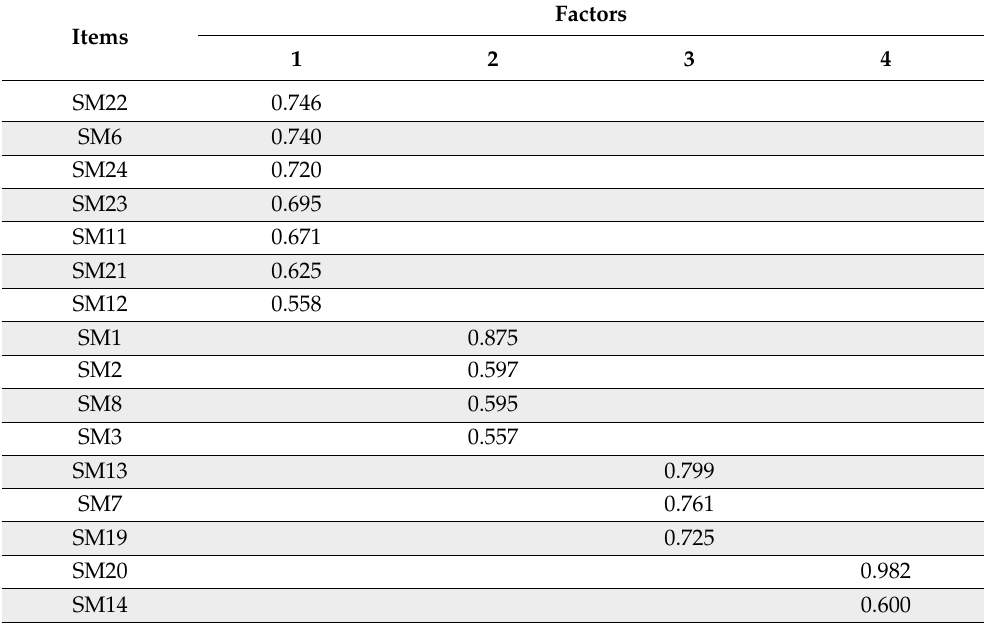
Table 3. EFA results.